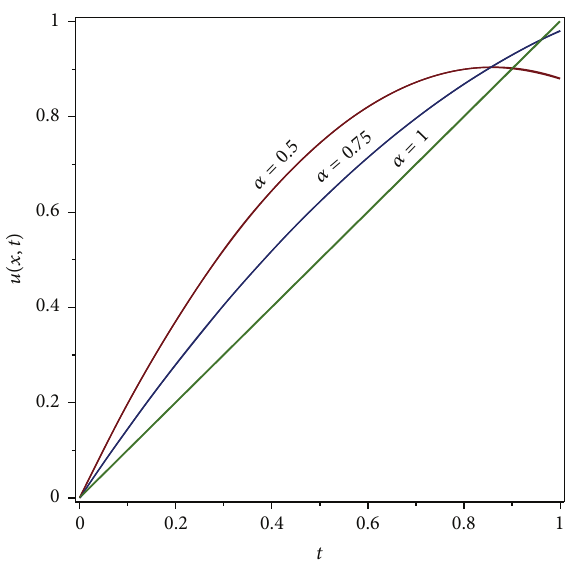
Figure 6: Plot of 𝑢(𝑥,𝑡) for various values of 𝑡 and different values of 𝛼 , 𝑥 = 1 .